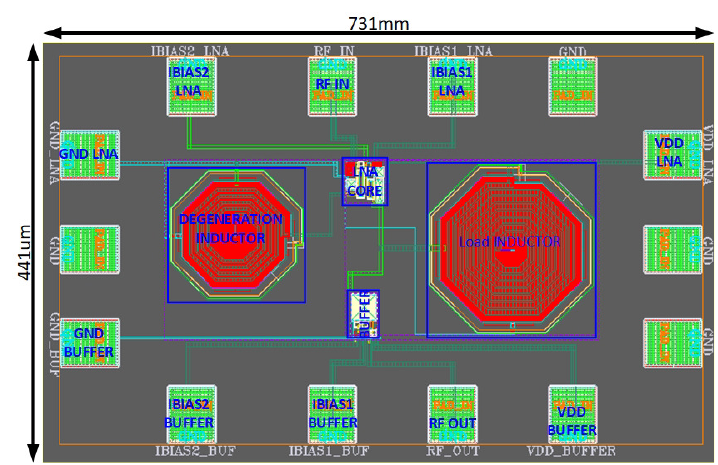
Figure 3. Layout photograph of the proposed LNA.